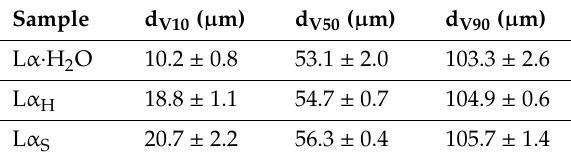
Table 1. Particle size distribution parameters of lactose carriers: α -lactose monohydrate, L α · H 2 O; hygroscopic anhydrous α -lactose, L α H ; stable anhydrous α -lactose, L α S . Mean values ± standard deviation ( n = 3).